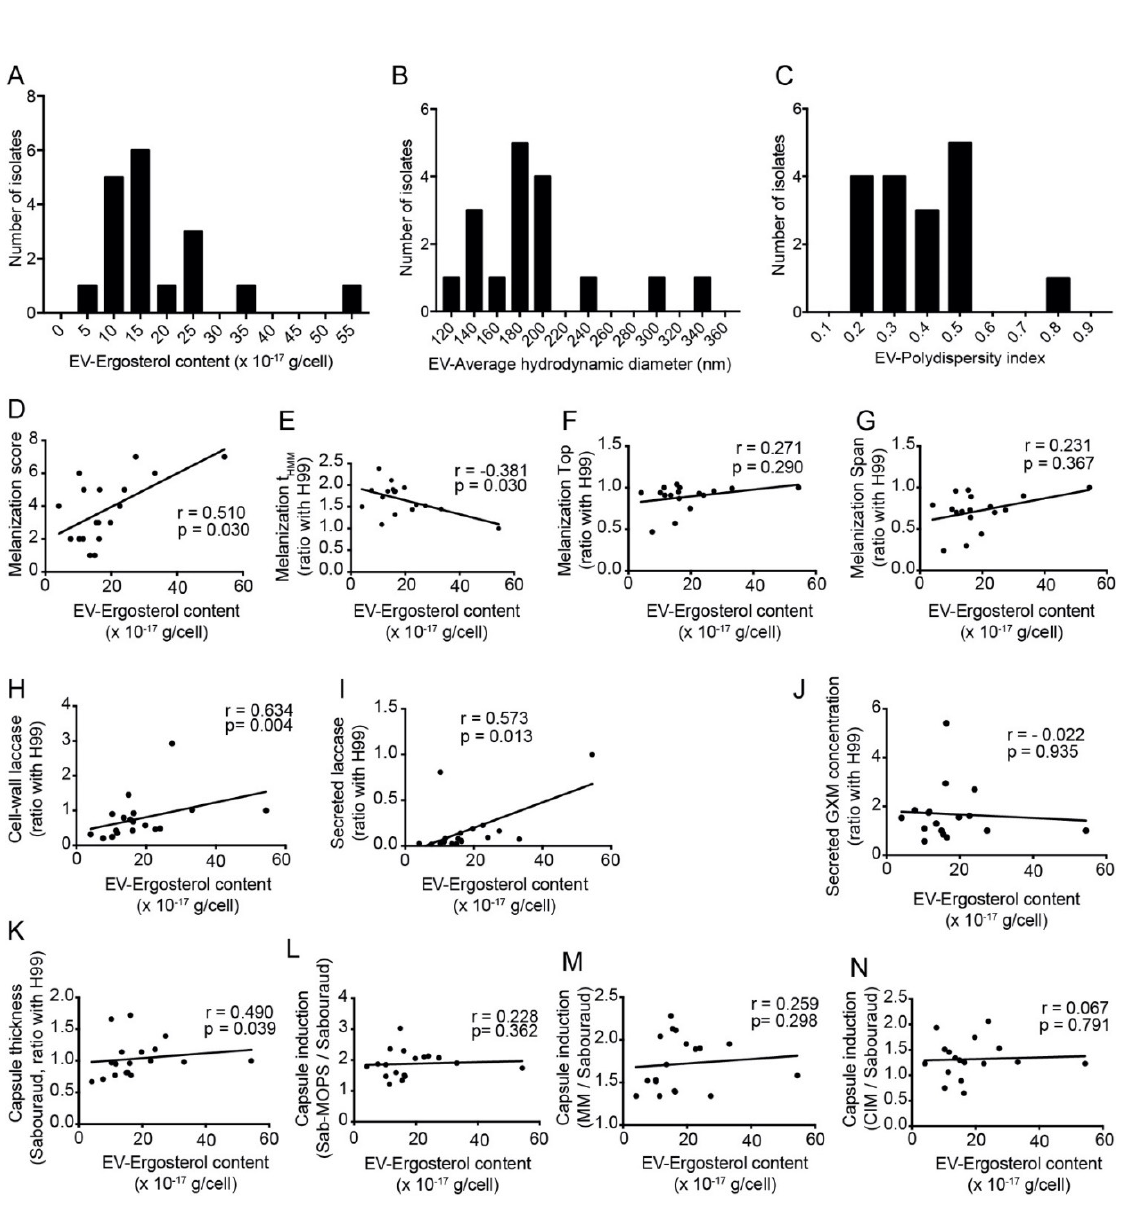
Figure 5. Extracellular vesicles (EVs) from clinical isolates. EV preparations were measured by dynamic light scattering (DLS). ( A ) Frequency distribution of the sterol quantification, an indirect measurement of the amount of vesicles secreted per cell. ( B ) Frequency distribution of the hydrodynamic diameter (intensity) and ( C ) frequency distribution of the polydispersity index. ( D ) Correlation between EV-ergosterol content and the melanization score. ( E ) Correlation between EV-ergosterol content and t HMM (represents the speed of melanization index from non-linear regression curve of median gray value). ( F ) No correlation between EV-ergosterol content with melanization Top (maximum melanization index from non-linear regression curve of median gray value) or ( G ) melanization Span (difference in median gray levels of the colony at the beginning and end of the experiment—difference between top and bottom). ( H ) Correlation between EV-ergosterol content with cell-wall laccase activity and ( I ) secreted laccase activity. ( J ) No correlation between EV-ergosterol content and se- creted GXM concentration. ( K ) Correlation between EV-ergosterol content and capsule thickness in Sabouraud (Sab) medium. ( L ) No correlation between EV-ergosterol content with capsule induction in medium Sab-MOPS, ( M ) capsule induction in minimal medium and ( N ) capsule induction in CO 2 -independent medium. All samples ( n = 18) were analyzed in duplicate and under the same conditions. All correlations were made with Spearman